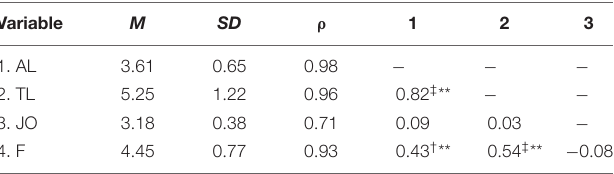
TABLE 1 | Correlation matrix, including means, standard deviations, and reliabilities.